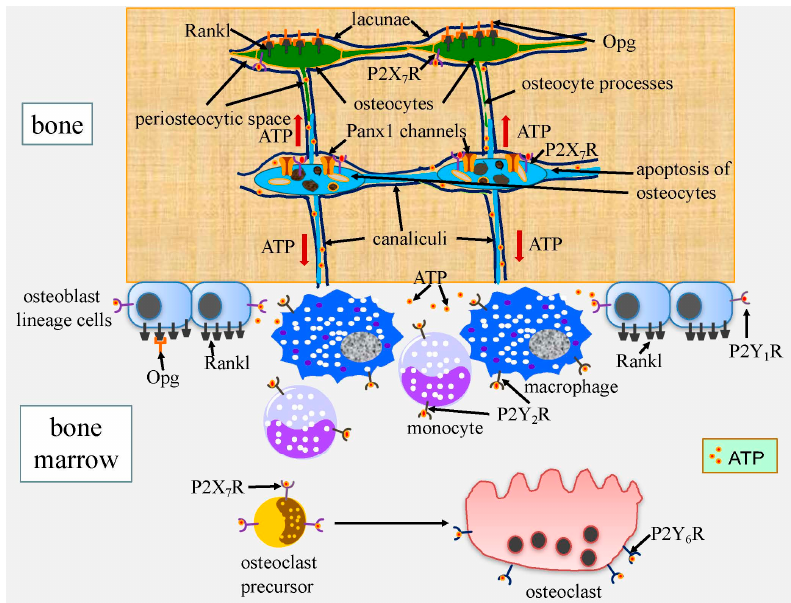
Figure 3. Induction of bone resorption by ATP released from apoptotic osteocytes. In apoptotic osteocytes, active Panx1 channels, which release ATP, are formed by the caspase-mediated cleavage of the C terminus. P2X 7 receptor (P2X 7 R), which is activated by extracellular ATP, forms a complex with Panx1 and enhances ATP release. Extracellular ATP recruits macrophages and monocytes through P2Y 2 R, increases nuclear factor κ -B ligand (Rankl) expression in osteocytes through P2X 7 R and in osteoblasts through P2Y 1 R, increases osteoclast survival through P2Y 6 R, and enhances the membrane fusion of osteoclast precursor cells to form multinucleated osteoclasts through P2X 7 R. The up-regulation of Rankl in osteocytes will reduce the release of osteoprotegerin (Opg), which is secreted by osteocytes, to the bone surface. It has been shown that Panx1 and P2X 7 R are required for Rankl up-regulation in osteocytes in fatigued bone. However, the functions of ATP released from apoptotic osteocytes shown here have not yet been directly proven in damaged